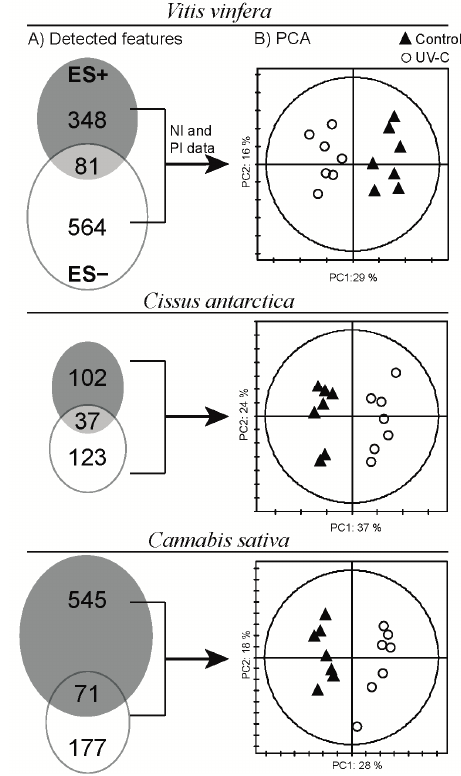
Figure 2. ( A ) Venn diagram showing the distribution of detected features in PI (grey circle) and NI (white circle) ESI UHPLC-TOFMS modes. The intercept shows the number of features detected in both modes; ( B ) Principal component analysis of concatenated PI and NI datasets scaled in unit